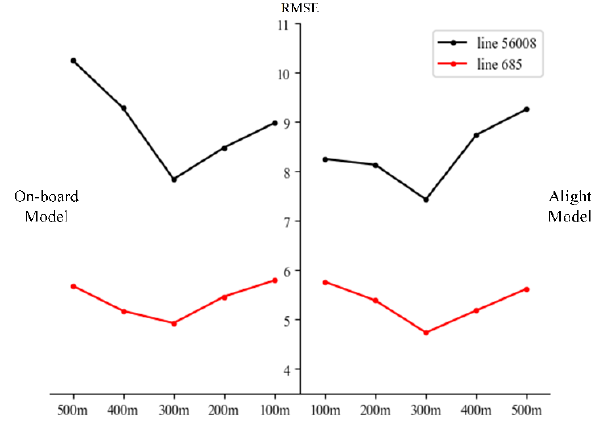
Figure 2. The RMSE and distance of passenger number prediction model in lines 56008 and